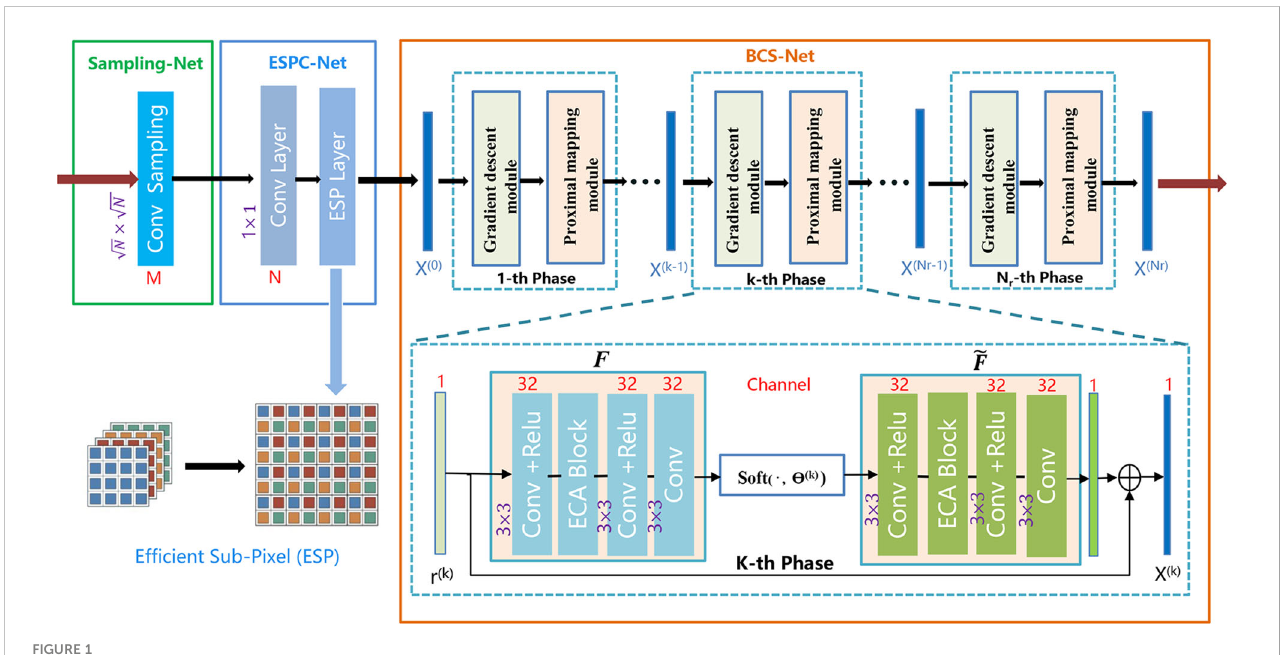
FIGURE 1 The schematic diagram of the proposed ESPC-BCS-Net consists of Sampling-Net, ESPC-Net, and